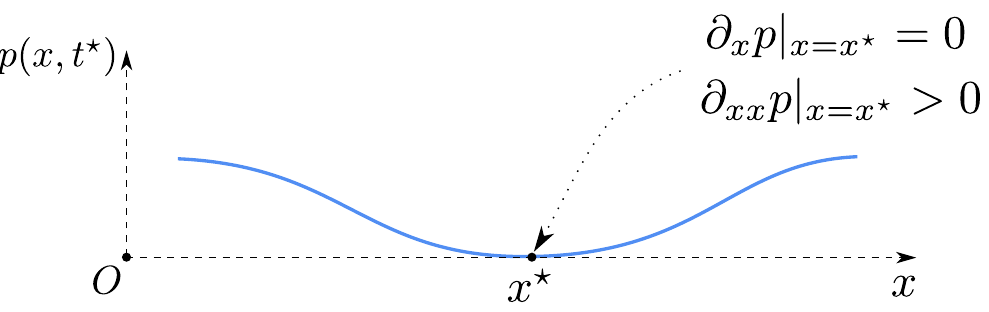
Figure A1. A schematic representation of the situation where the solution p ( x , t ) attains a zero value at some point x (cid:63) >